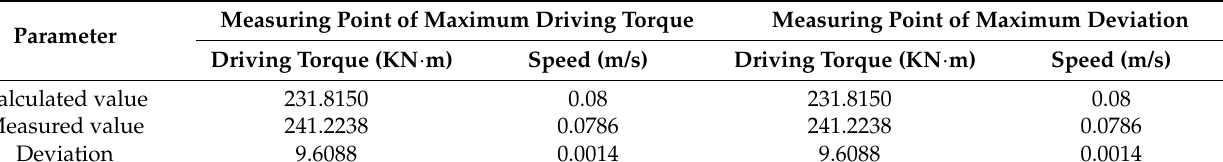
Table 1. Comparison between experimental and calculated data of uniform motion.